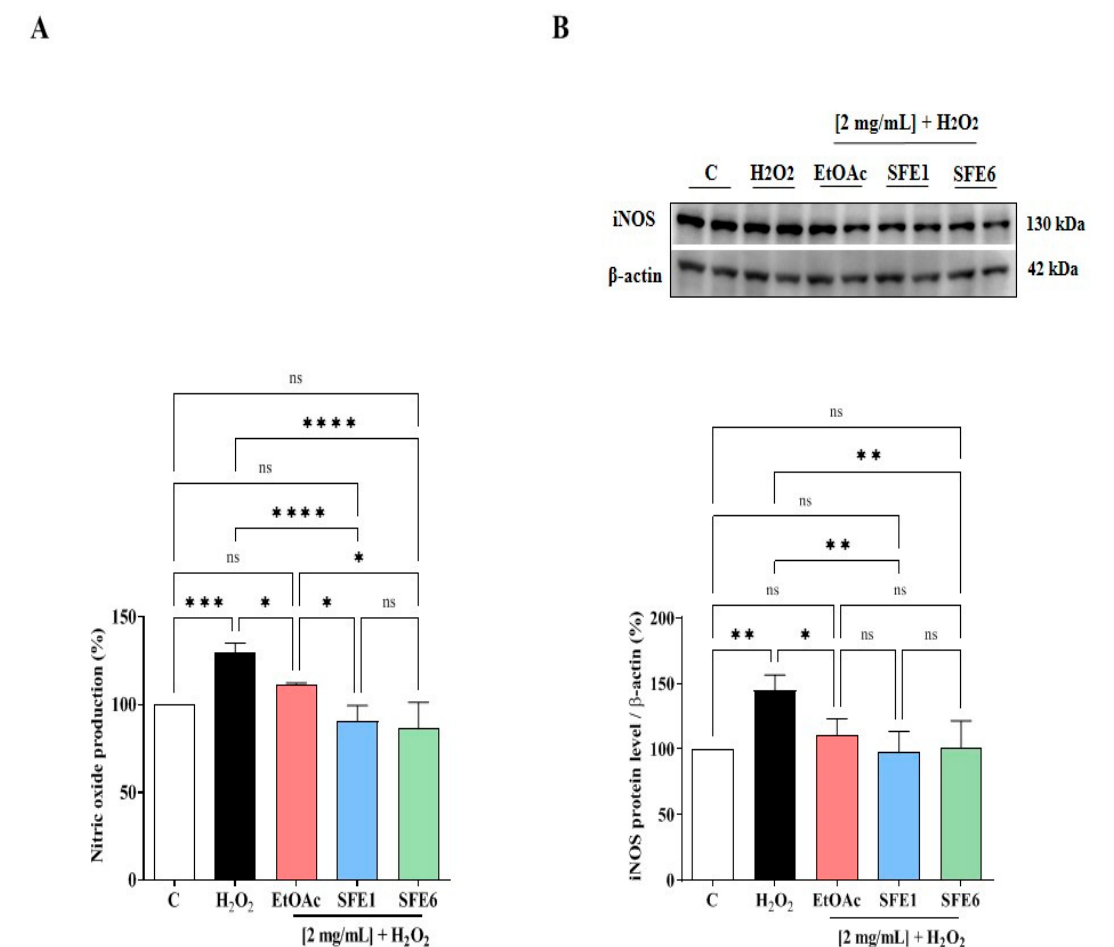
Figure 6. Effect of EtOAc, SFE1 and SFE6 on the H 2 O 2 (1 mM)-induced NO production ( A ) and inducible nitric oxide synthase (iNOS) protein levels ( B ) in human intestinal Caco-2 cells. The data points represent the averages ± s.d. of four independent experiments in duplicate. All data sets were analyzed by one-way ANOVA followed by Tukey’s post-hoc test. C: control sample; ns: not significant; (*) p < 0.05, (**) p < 0.01, (***) p < 0.001 and (****) p < 0.0001.